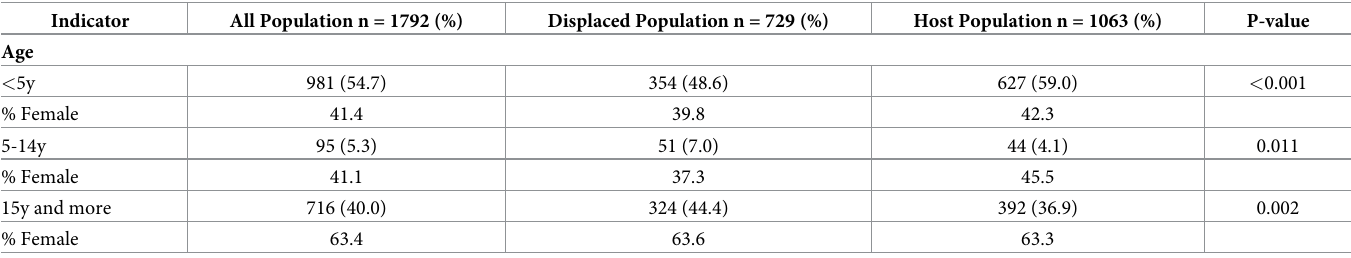
Table 1. Age-sex distribution of the patients attending DTCs, April-December 2018, Cox’s Bazar, Bangladesh. Indicator All Population n = 1792